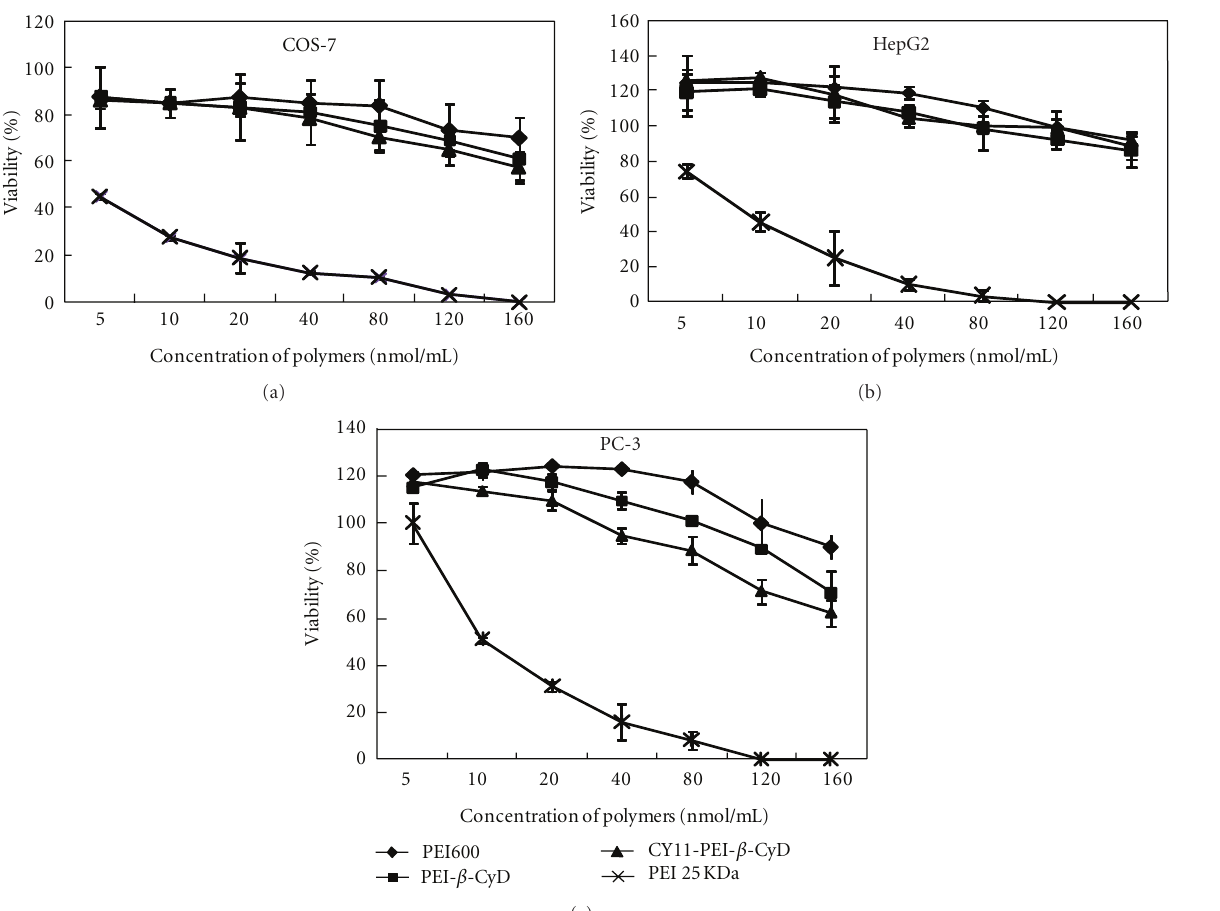
Figure 4: The cytotoxicity of PEI600, PEI- β -CyD, CY11-PEI- β -CyD, and PEI25KDa against (a) COS-7, (b) HepG2, and (c) PC-3 cells. The cells were treated with polymer of di ff erent concentrations for 4h in a serum-containing medium. Cell viability was determined using MTT assays and expressed as percentages of the control. When the concentration of the polymer was < 20 nmol/mL, the toxicities of the polymers were similar ( P > 0 .